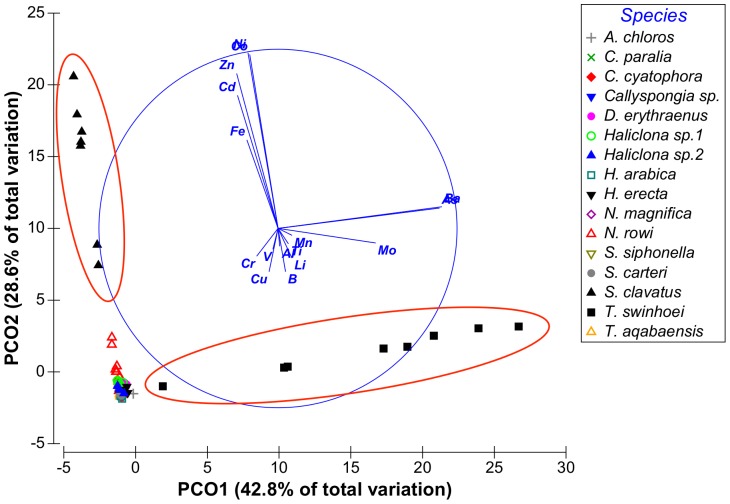
Distribution of sponge samples along PCOI vectors 1 and 2.Species of interest are circled in red.